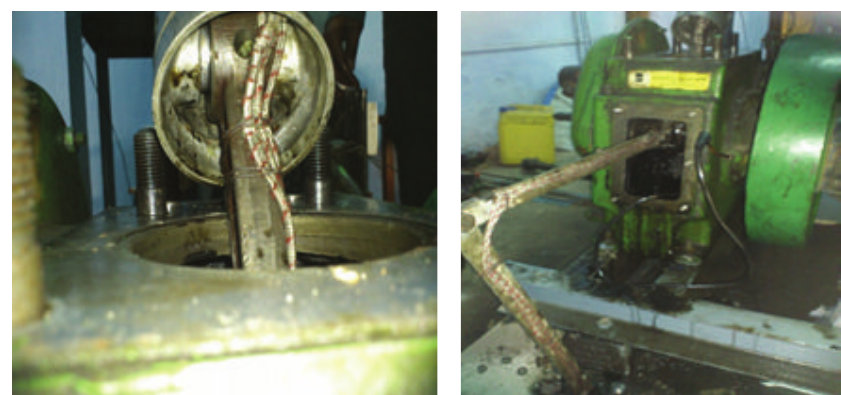
Figure 4: Experimental